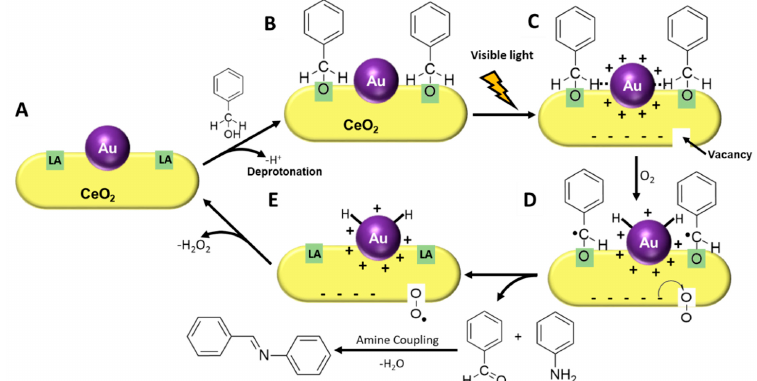
Figure 3. Schematic representation of the proposed photocatalytic mechanism. The LA sites ( A ) enable the adsorption of benzyl alcohol (B) , via a deprotonation pathway. Localized surface plasmon